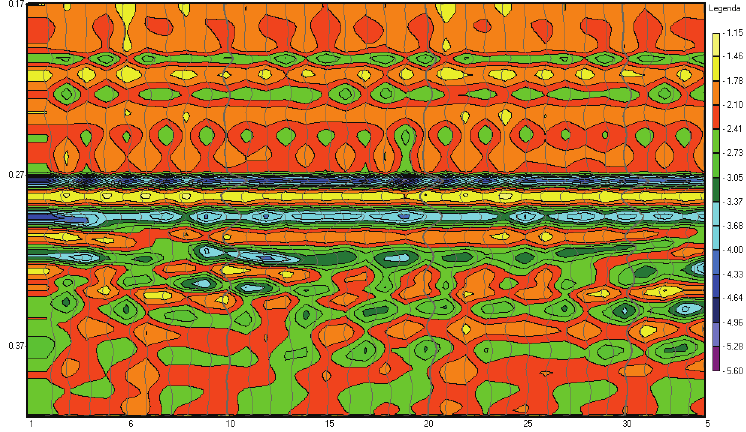
Fig. 10. Synthetic pseudoimpedance acoustic section with predictive deconvolution; signal parameters: dominant frequency f 0 = 40 Hz, initial phase φ 0 = 0, the ratio of dominant frequency to dumping factor f 0 / β = 1, noise 0%